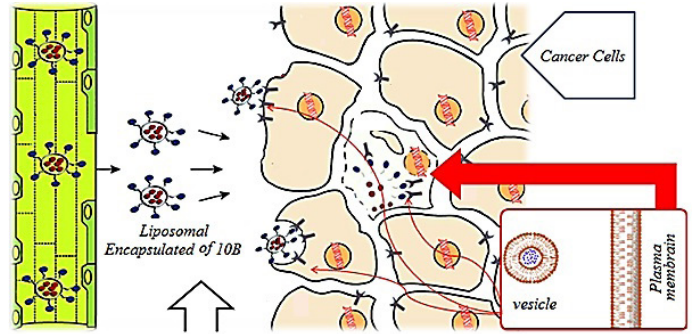
Fig. 4. Overall schematic of the nanodrug entrance into the blood and tissue